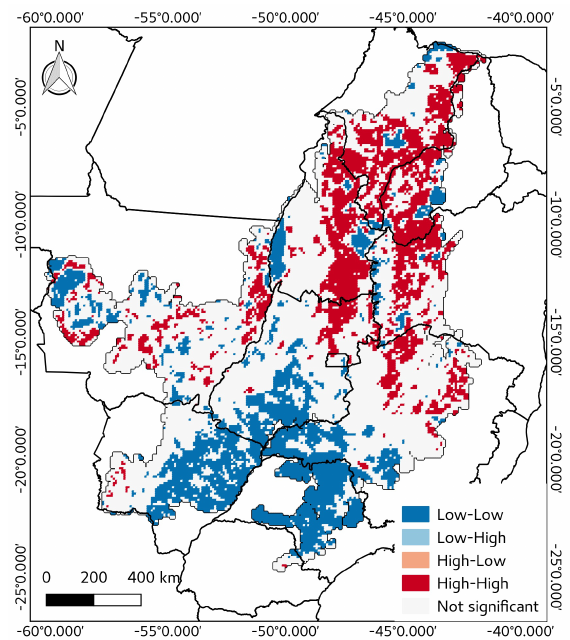
Figure 5. LISA map for LSS. Red patches indicates the predominance of agricultural landscapes more oriented to a land sharing pattern, while blue patches indicates land sparing pattern predominance in the landscape.